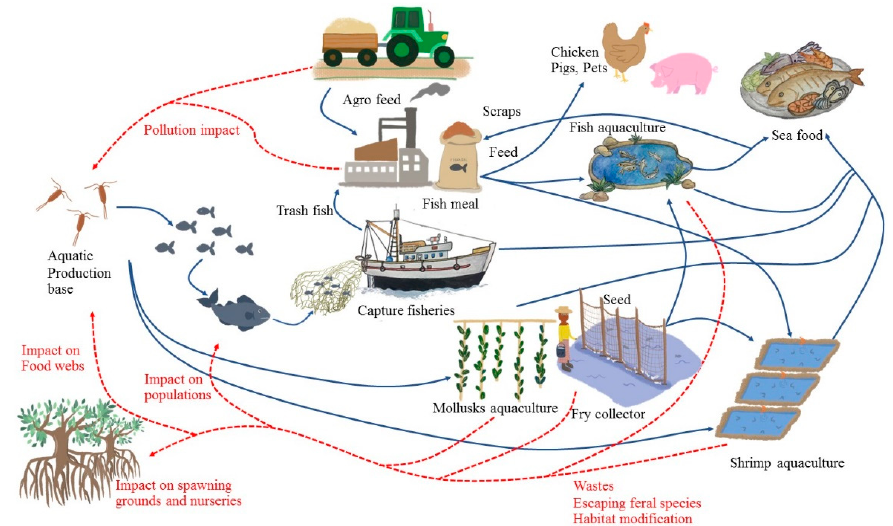
Figure 3. The ecological links between aquaculture and capture productions. The blue lines demonstrate the relationship between capture and aquaculture production to the human consumption of seafood. The hatched red lines indicate the negative impacts of the productions on mangrove and marine ecosystems. Adapted from Naylor et al. [24].